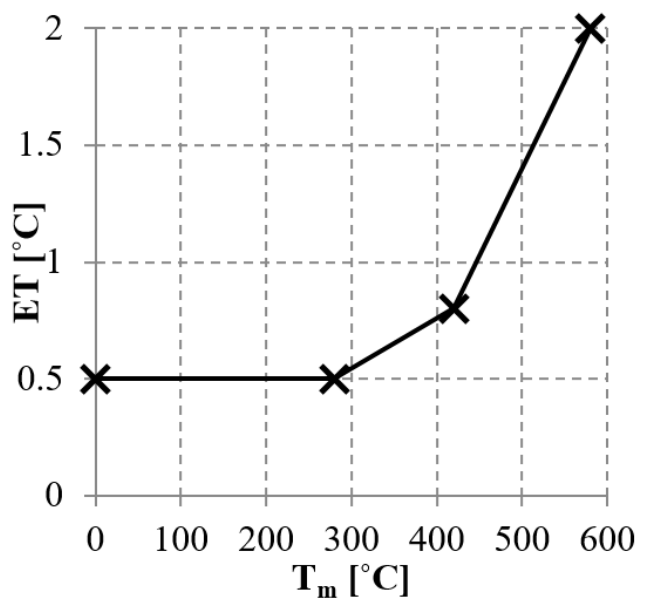
Figure 2. The course of the error in temperature measurement ET, depending on the measured temperature.